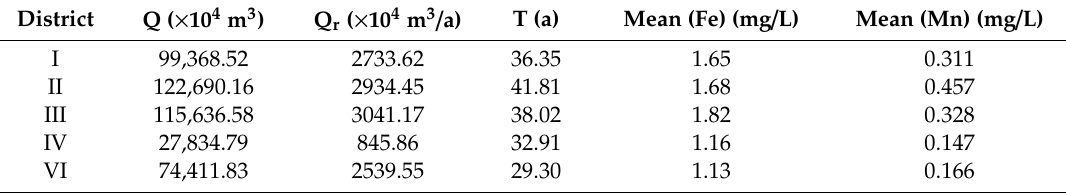
Figure 7. Relationship between groundwater turnover time and concentration of Fe ( a ) and Mn ( b ) in groundwater. Table 6. Calculation results of turn over time of groundwater in different calculation districts.